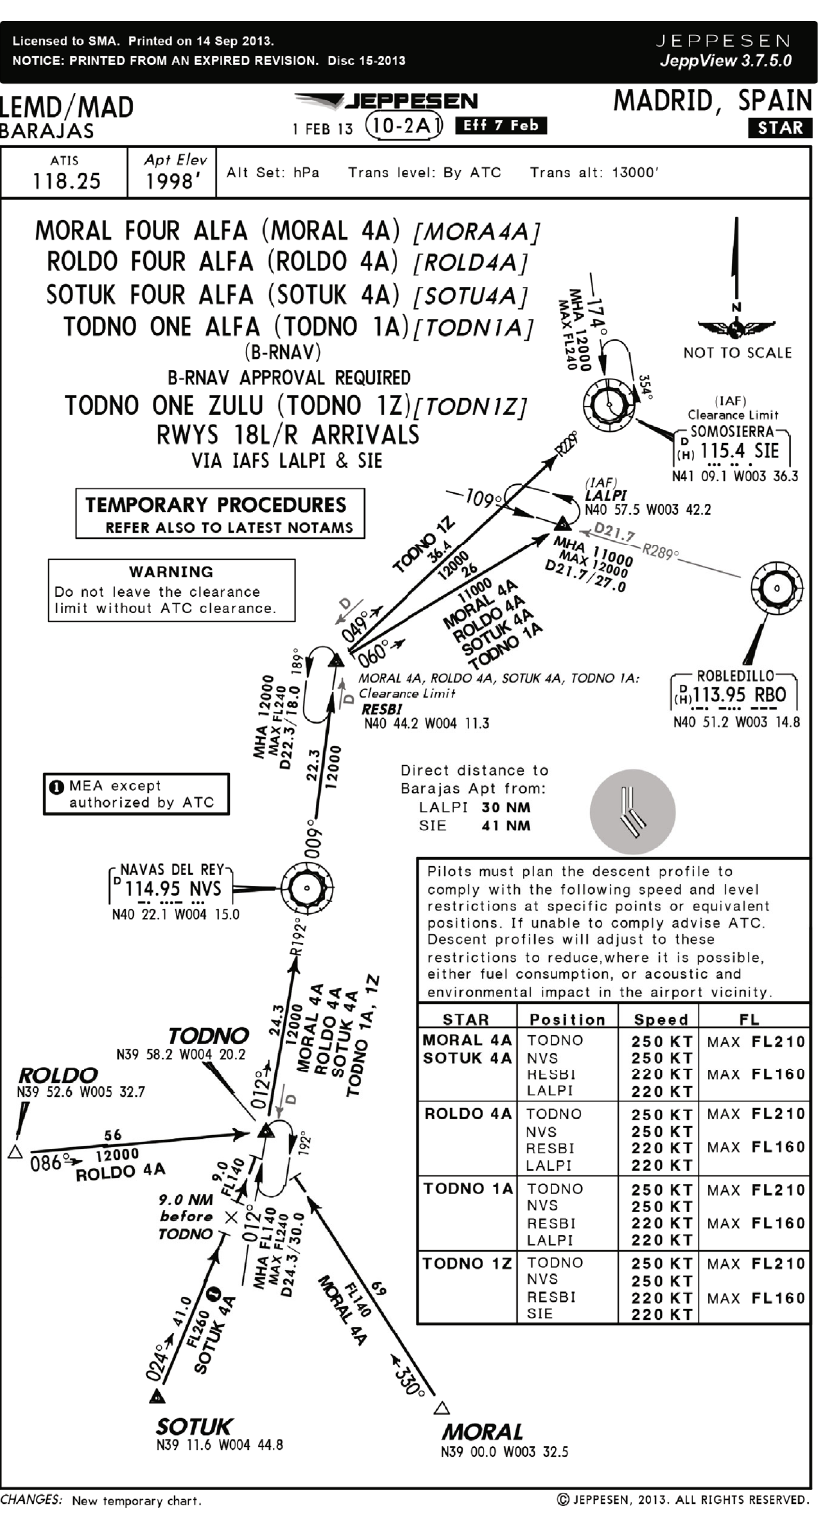
Figure 3: Chart of the Adolfo Suárez Madrid-Barajas (LEMD/MAD) STAR